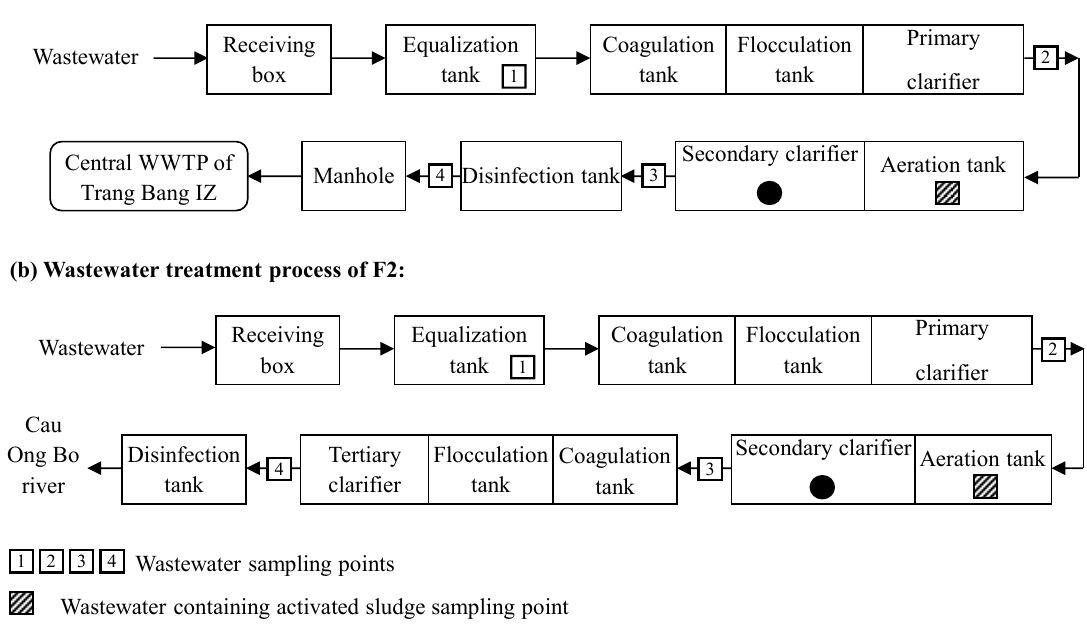
Figure 1. Wastewater treatment processes and sampling points at ( a ) Hoa Sen factory—F1 and ( b ) Chyang Sheng factory—F2.